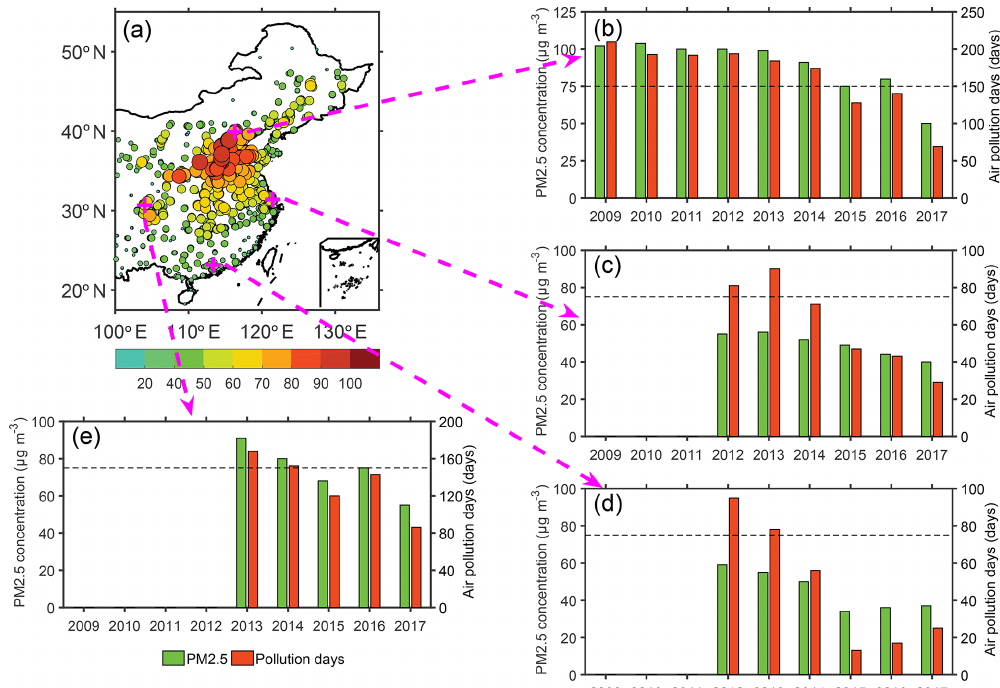
Figure 1. Observed PM 2 . 5 pollution conditions over eastern China during the past years. (a) Annual averaged PM 2 . 5 concentration (µgm − 3 ) for the years of 2015–2017. (b) Variations in annual averaged PM 2 . 5 concentration (green bars) in Beijing city and the corresponding number of the severe PM 2 . 5 pollution days (red bars). The severe pollution days are defined as the daily averaged PM 2 . 5 concentration exceeding 75µgm − 3 . Panels (c) , (d) , and (e) are similar to (b) , but for the results of Shanghai, Guangzhou, and Chengdu city,